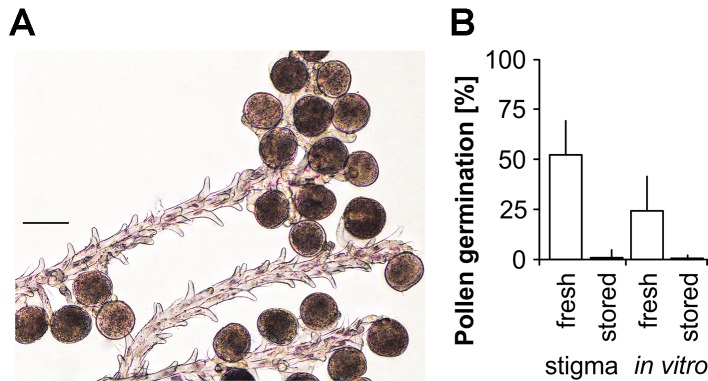
Improved wheat pollen tube growth in the presence of the stigma. (A) Pollen tubes grew toward stigma. The selected image section represents an ideal situation of pollen tube growth. (B) Comparison of stigmatic pollen germination and in vitro germination on medium using fresh pollen and pollen stored at ambient conditions for > 60 min. Mean and standard deviation of n = 14 replicates using >70 pollen each are shown for the line TRI 9102. The least significant differences at P < 0.05 (LSD5%) was estimated at 10.0%. Scale bar = 50 µm.